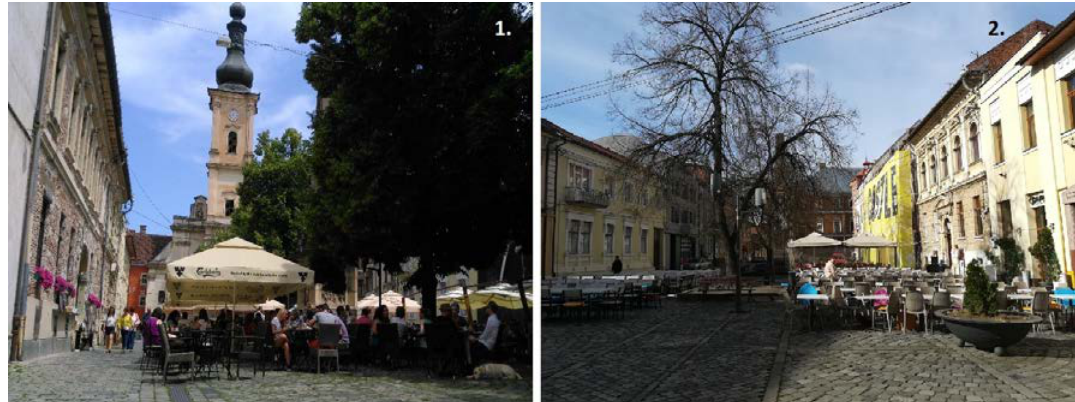
Figure 5: Recreational activities in Museum Square. View: 1. towards east, 2. towards west Source: 1 - Emanuel-Cri stian ADOREAN, 2016© and 2 - Alexandru- Sabin NICULA, 2019© Mihai Viteazul